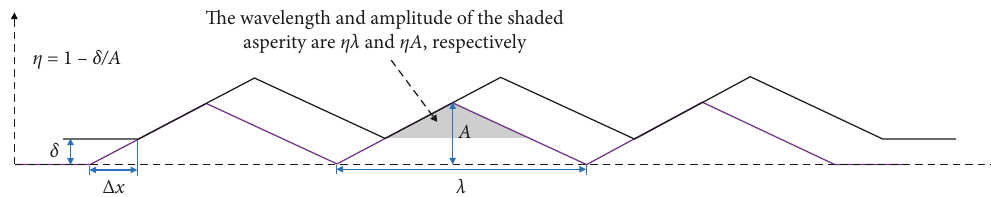
are the total projected asperity area and the area of a single asperity, respectively. σ 0 , σ is a high normal stress under which the peak dilation angle is i 1 n2 and σ , respectively. dy and dy represent the normal displacement increments n1 n2 1 2 and σ , respectively. dx is the shear displacement increment. n1 n2 The wavelength and amplitude of the shaded asperity are ηλ and ηA , respectively